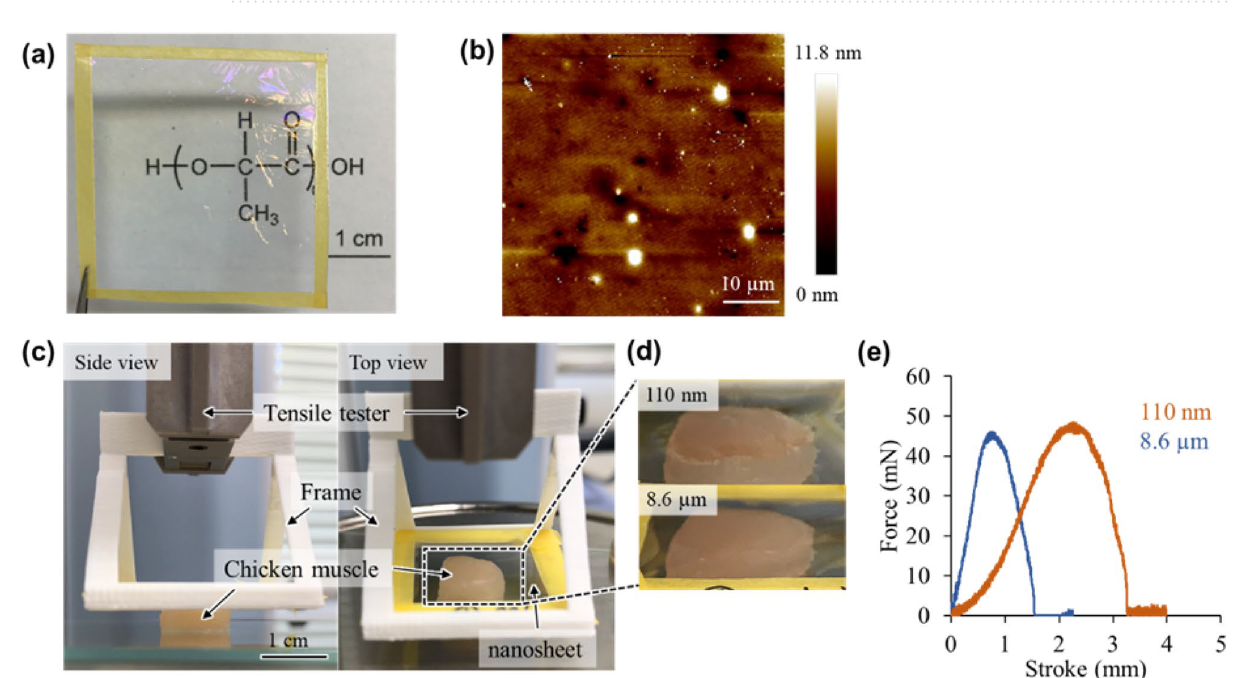
Figure 3. Optical, morphological and mechanical characterization of PDLLA nanosheets. ( a ) An optical image of PDLLA nanosheet suspended by a tape frame. ( b ) AFM height image of PDLLA nanosheet. ( c ) Experimental setup of tack-separation test; PDLLA nanosheet supported by the 3D-printed plastic frame interfacing biological tissue (i.e., chicken muscle), which was pulled by tensile tester. ( d ) Optical images of PDLLA thin films with different thickness (110 nm and 8.6 µm), conforming to the chicken muscle. ( e ) Force–stroke curves of different PDLLA thin films examined by the tack-separation